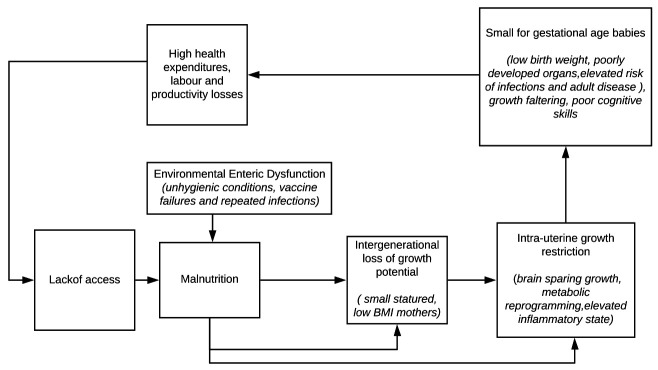
Intergenerational effects of malnutrition and inequality.